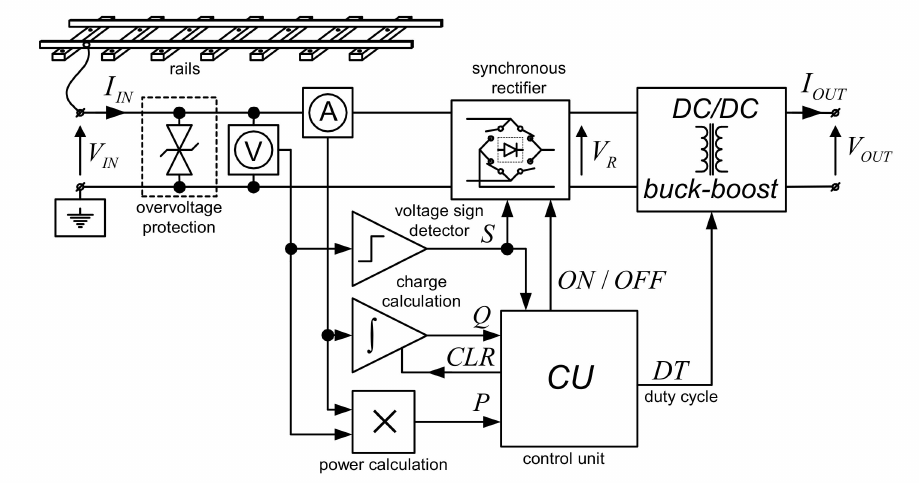
Figure 13. The stray current energy harvesting device with maximum power point and charge flow balancing